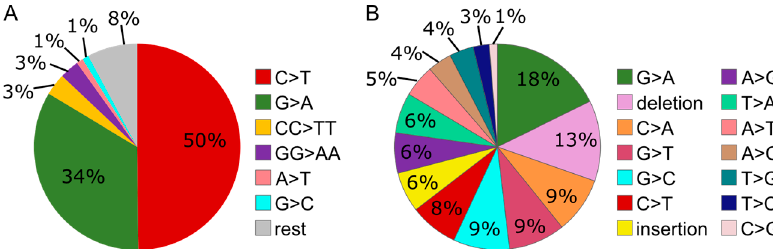
Figure 4. Distribution of mutation types caused by UV (control / parent only) ( A ) or MMS (control / parent only) ( B ) in the supF reporter plasmid replicated in control cells (Hap1 parent cell line). “Rest” accounts for mutations with a prevalence <1%.